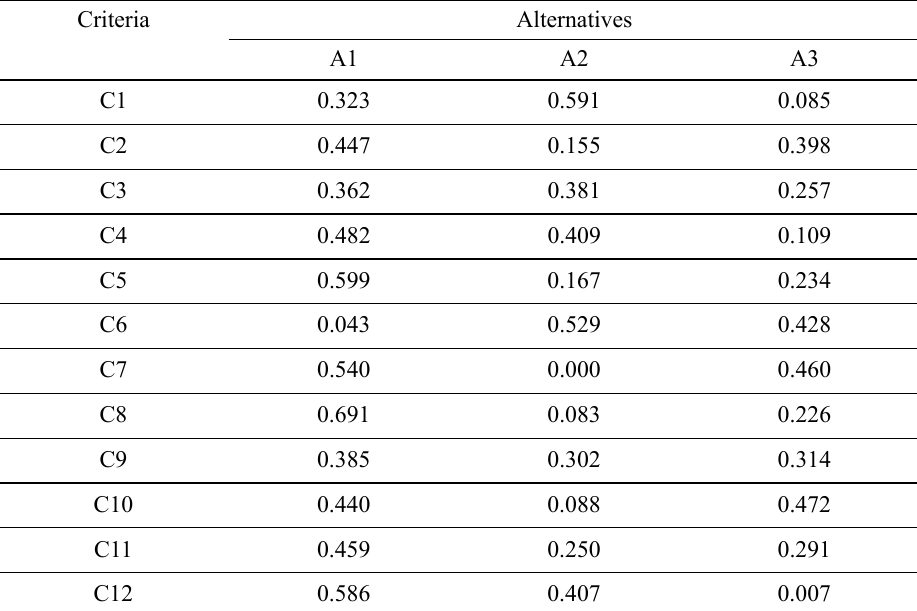
Table 10. Fuzzy weights of the alternatives under each criterion